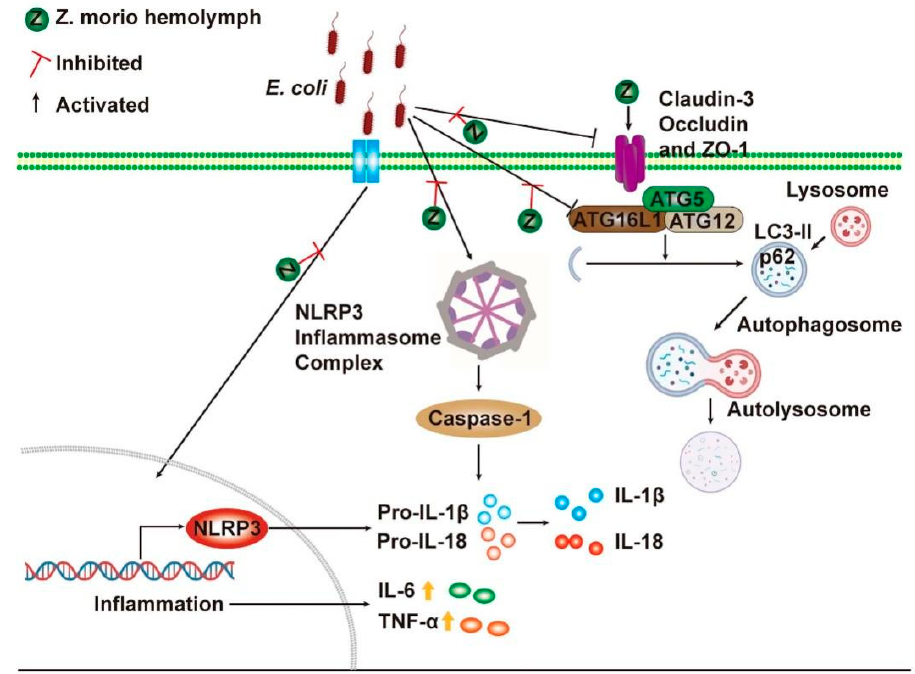
Figure 8. The mechanism of Z. morio hemolymph in anti-mastitis and improved blood milk barrier integrity. Z. morio hemolymph alleviates E. coli -induced inflammatory response of mammary gland through restraining NLRP3 signaling pathway and promoting ATG5/ATG16L1-mediated autophagy signaling pathway, and Z. morio hemolymph also enhances the integrity of blood-milk barrier via regulating the expression of TJs including Claudin-3, Occludin and ZO-1.